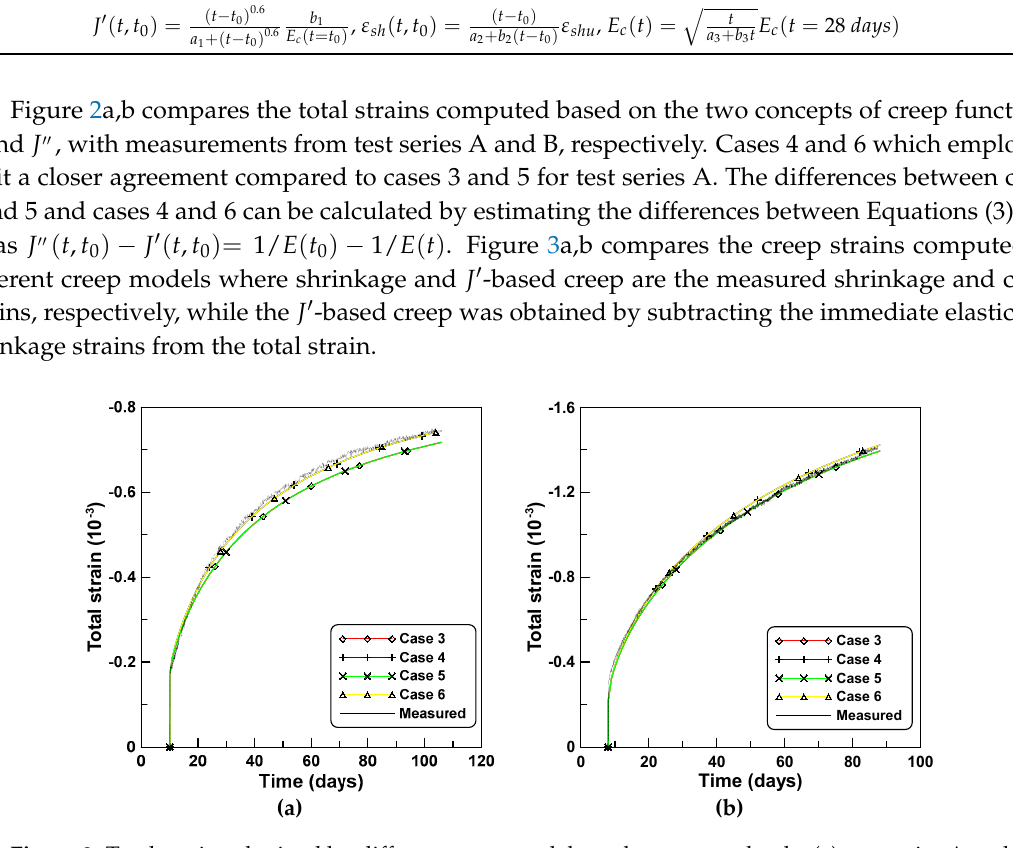
Figure 2. Total strains obtained by different creep models under constant loads: ( a ) test series A and ( b ) test series B.